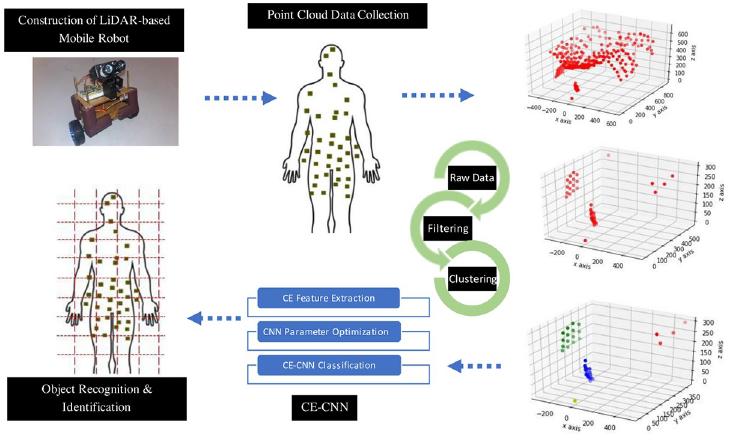
Fig 9. Flow of the proposed feature extraction technique for object